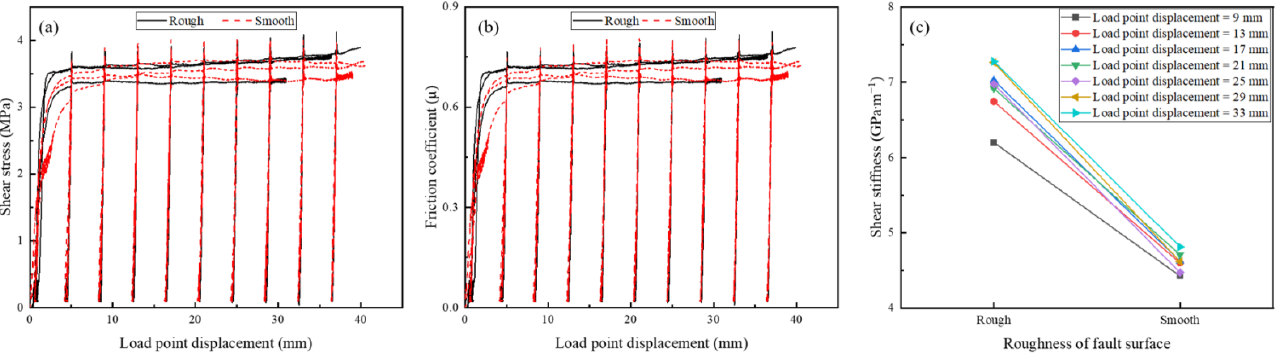
Figure 7. The test results with two kinds of fault surfaces. The surface roughened with #60 sandpaper is defined as a rough surface, and the Z 2 s is 0.7~2.1. The surface roughened with #1000 sandpaper is defined as a smooth surface, and the Z 2 s is 0.12~0.34. ( a ) Trend of shear stress on faults with slip displacement. ( b ) Trend of friction coefficient on faults with slip displacement. ( c ) Trend of the average shear stiffness on faults with roughness of fault surfaces.